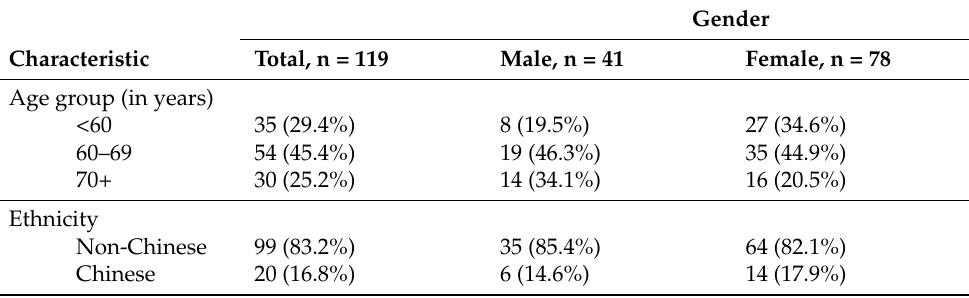
Table 1. Characteristics of participants.